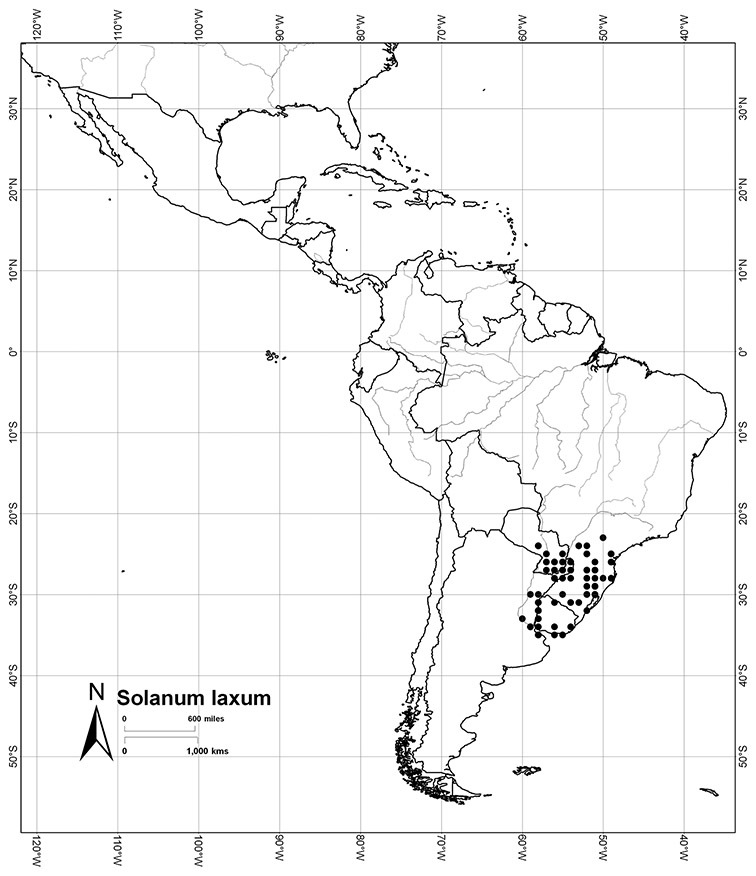
Distribution of Solanum laxum Spreng.